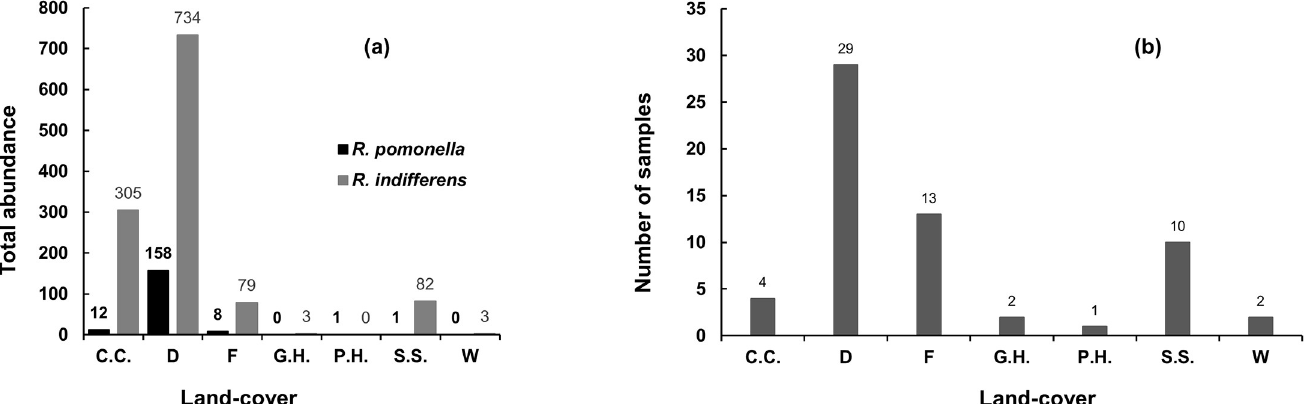
Fig 2. Abundance of R . pomonella and R . indifferens in Washington State, U.S.A. (A) = total abundance by land-cover, and (B) = sample frequency by land-cover. C.C = cultivated crops; D = developed areas; F = forest; G.H. = grassland-herbaceous; P.H. = pasture-hay; W = wetland; S.S. =